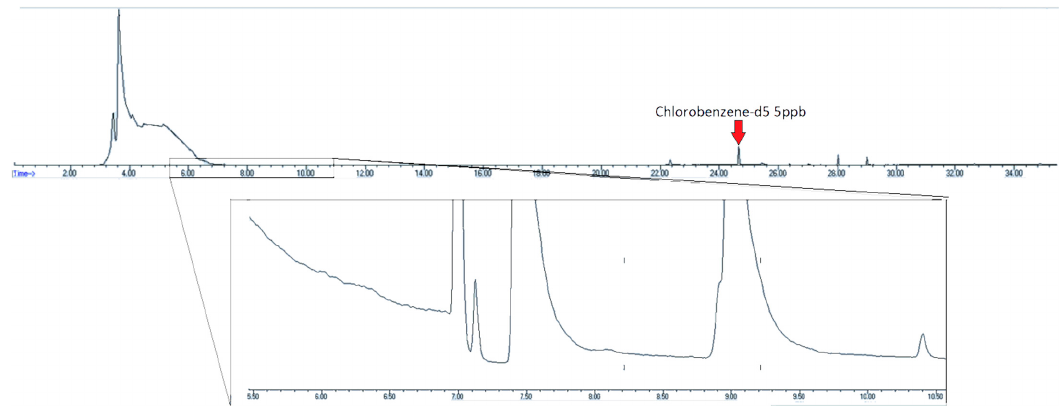
Figure 8. Chromatogram of contaminated air canister post-proprietary cleaning. Insert–SIM trace of m / z 29. EtO concen- tration–<LOQ.